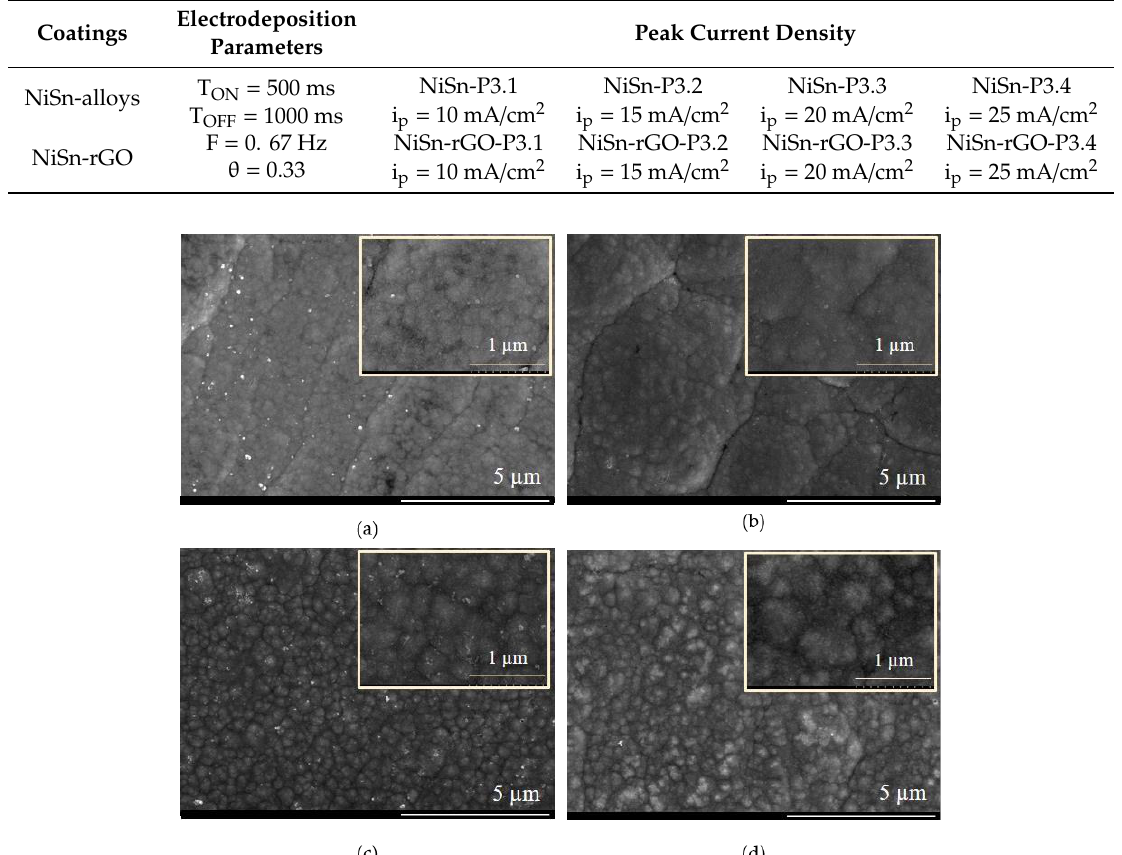
Table 3. Operating parameters for the electrodeposition of NiSn-alloy and NiSn-rGO from ILEG at various peak current densities.